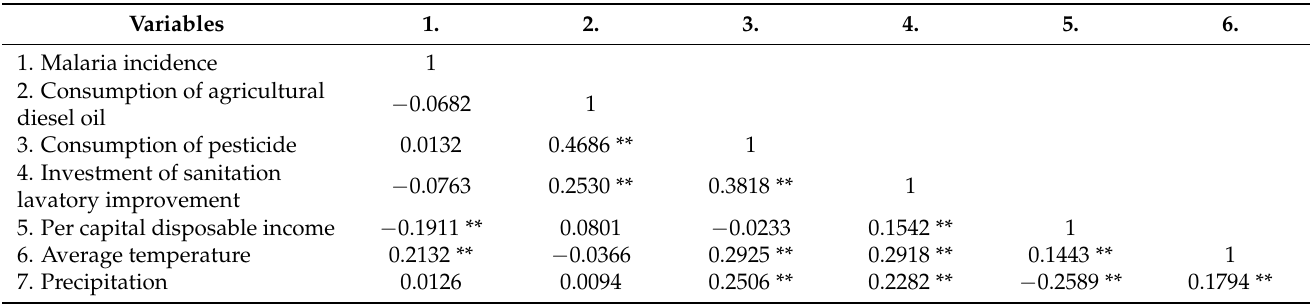
Table 3. Correlations matrix.